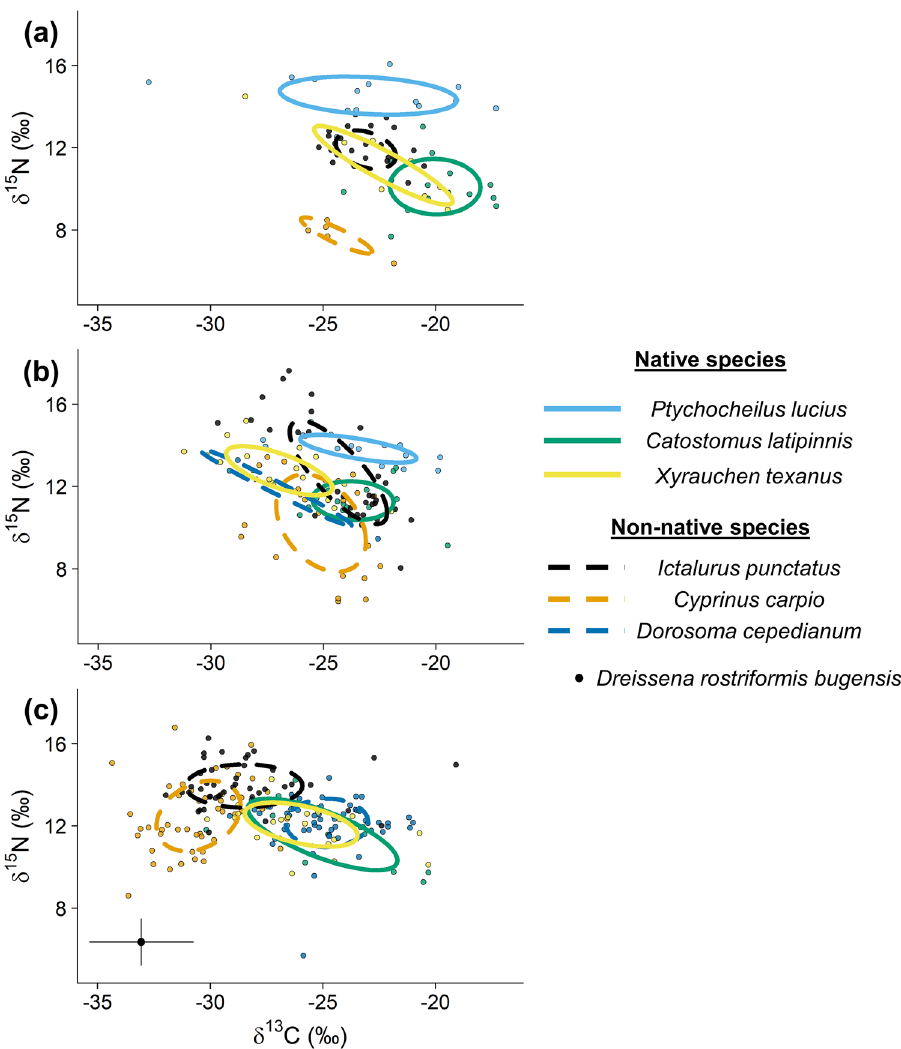
Figure 4. Isotope biplots from fish assemblages in the river upstream on the San Juan River, Utah ( a ), river downstream ( b ), and in Lake Powell reservoir ( c ). Ellipses are standard area ellipses corrected for samples size (SEAc; Jackson et al. 2011). Some species present in assemblages differ among panels (i.e., P. lucius and D. cepedianum ). Filter-feeding Quagga mussels ( Dreissena rostriformis bugensis ) were only collected in the reservoir (dot represents the mean and lines are